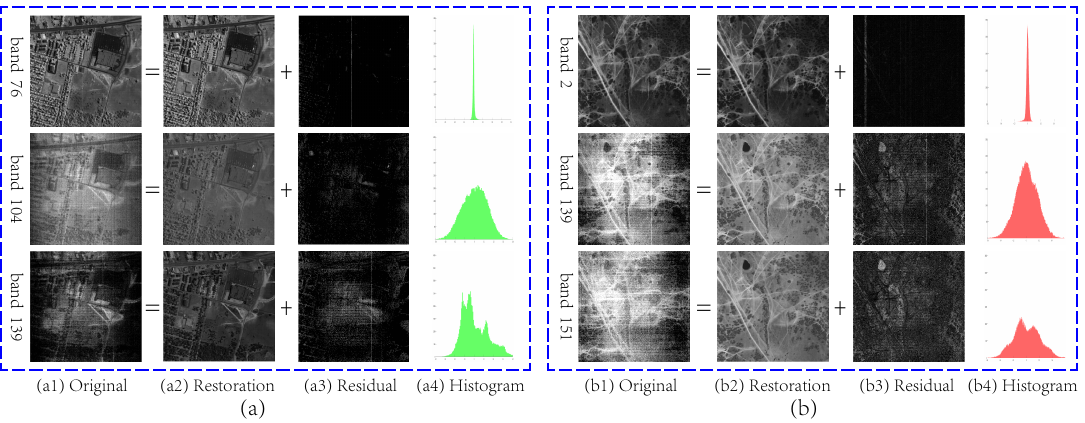
Figure 1. The distinctness of noises among different bands of hyperspectral images (HSIs). ( a ) Bands 76, 104 and 139 of the Urban HSI dataset; ( b ) Bands 2, 139 and 151 of the Terrain HSI dataset. (a1) and (b1): Original images, (a2) and (b2): restored images, (a3) and (b3): noises extracted by our proposed method, (a4) and (b4): histogram of noises in the same